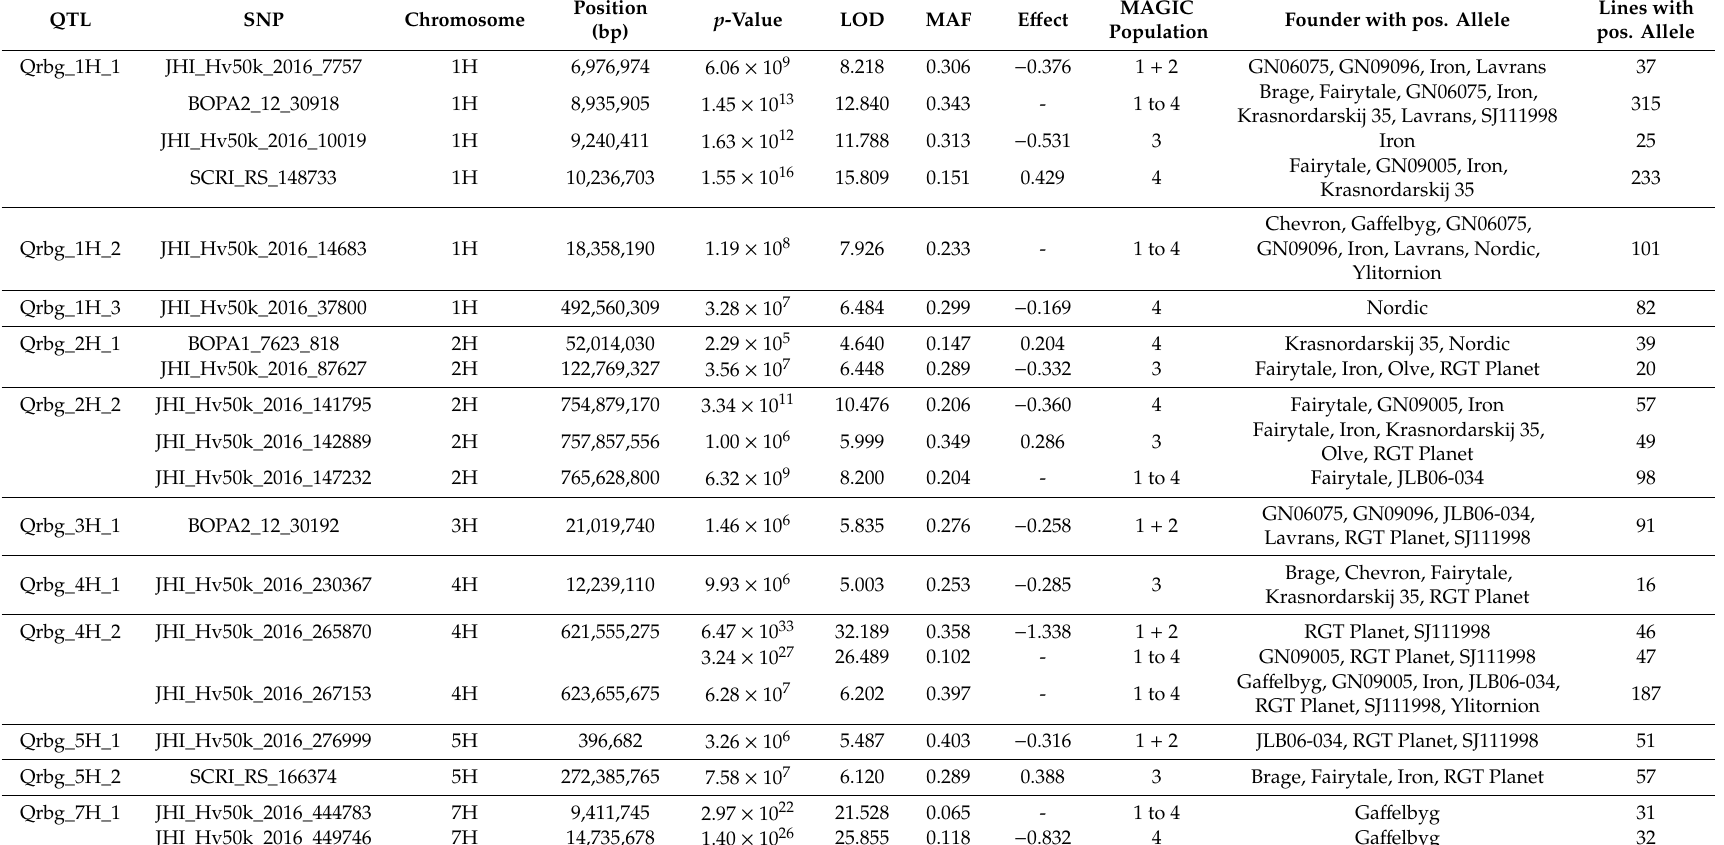
Table 5. Quantitative trait locus / loci (QTL) for powdery mildew resistance identified in genome-wide association studies in four barley MAGIC populations, markers significantly associated with these regions and their physical locations, as well as founders and lines carrying the positive alleles. Complete lists can be found in Tables S2 and S4.